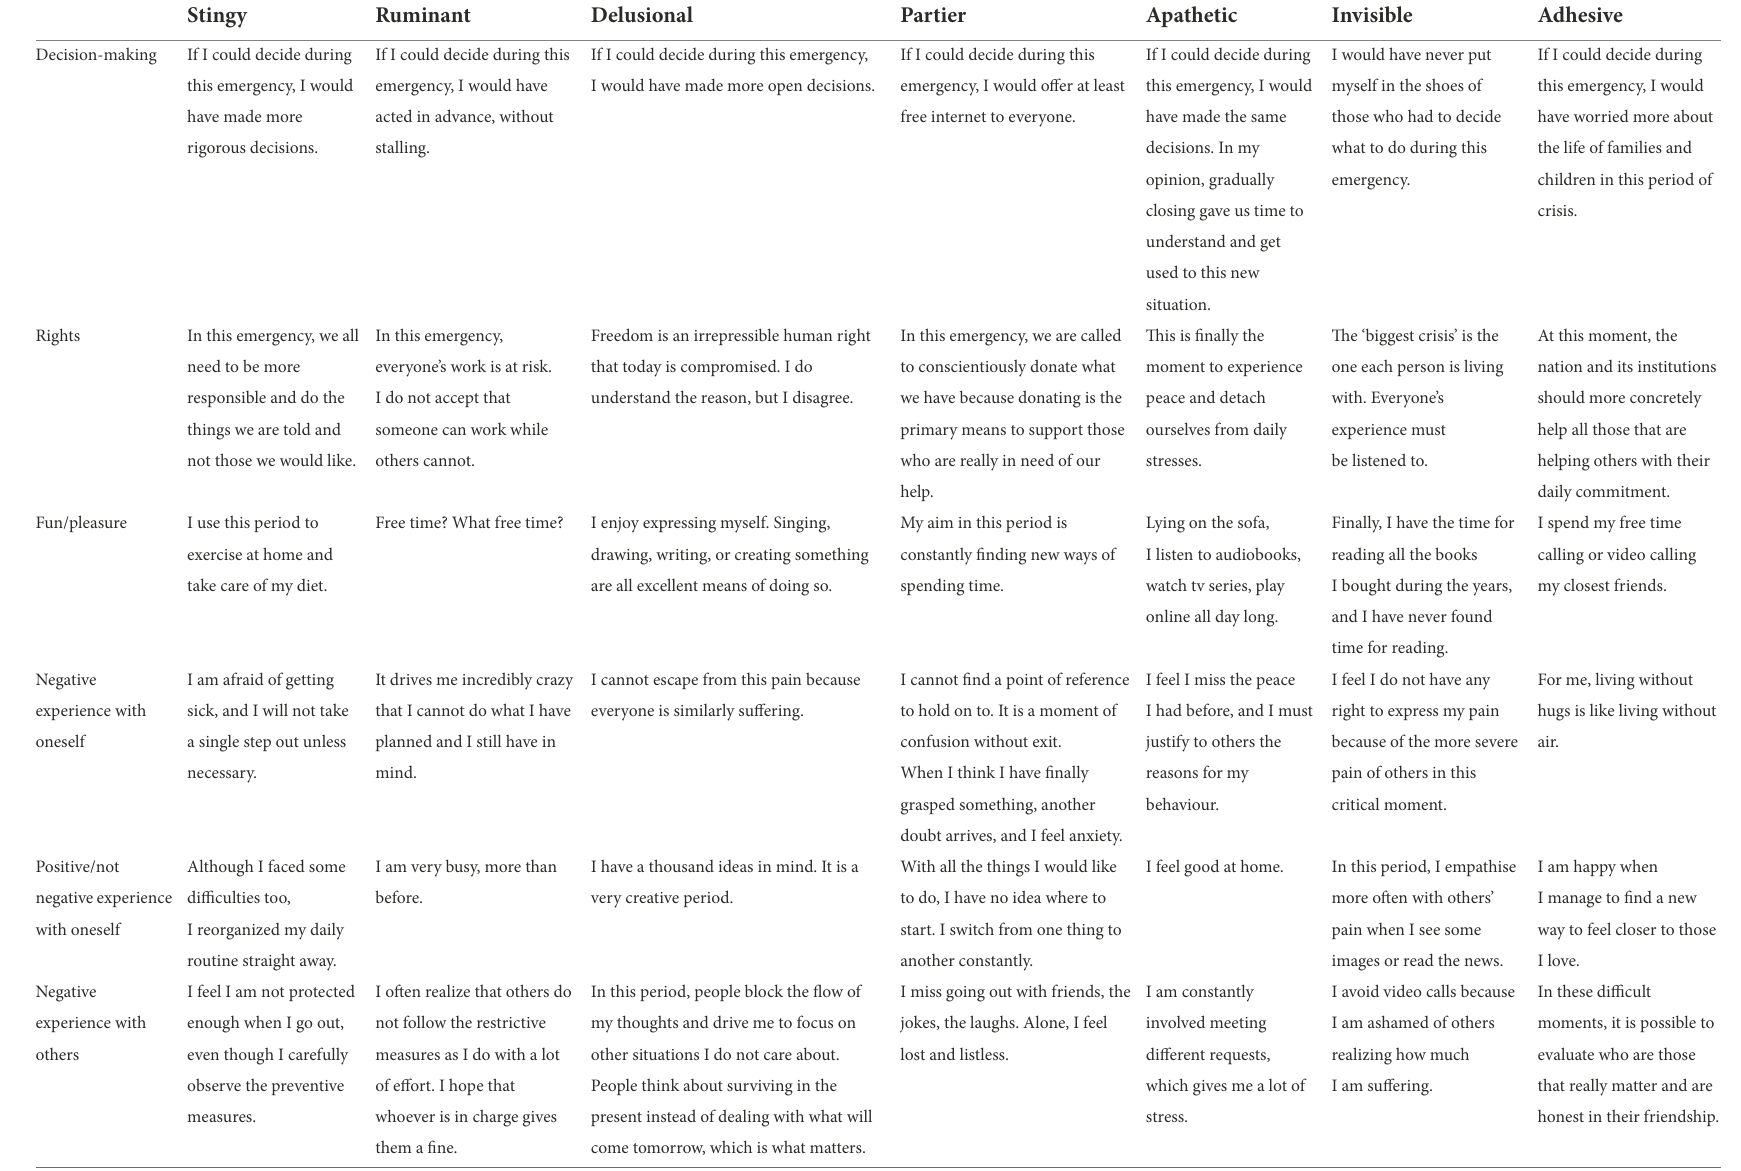
TABLE 3 Questionnaire 2 items: For each dimension (see rows), the researcher reads the seven statements, and the participants choose the ones better describing themselves during the lockdown.